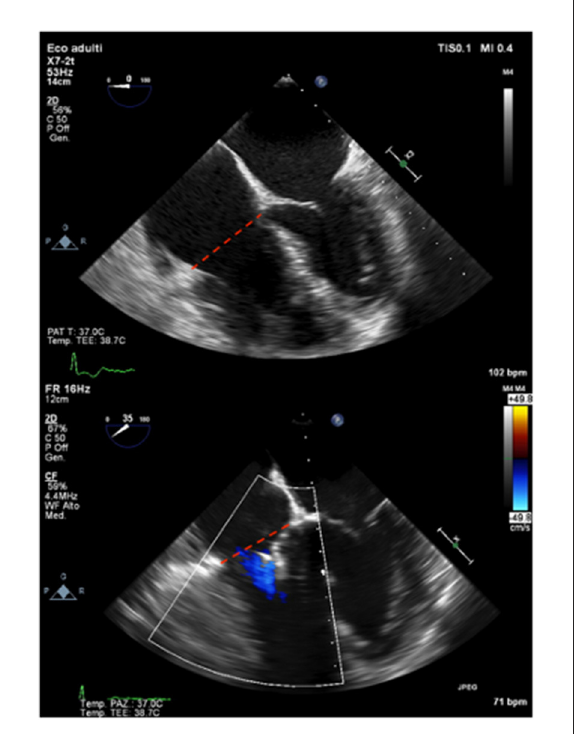
FIGURE1 A case of RV reverse remodeling after percutaneous tricuspid leaflet repair. Baseline TEE (upper panel) and final result immediately after Triclip (bottom panel) showing early and significant reduction of TV annulus in end-diastole (red dashed